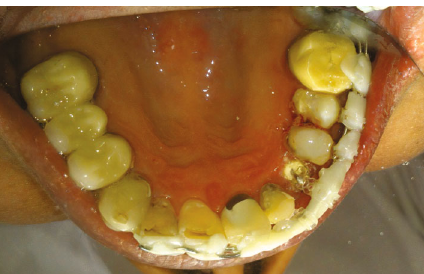
Figure 5: Occlusal view of fi xed appliance used for orthodontic extrusion of four teeth.